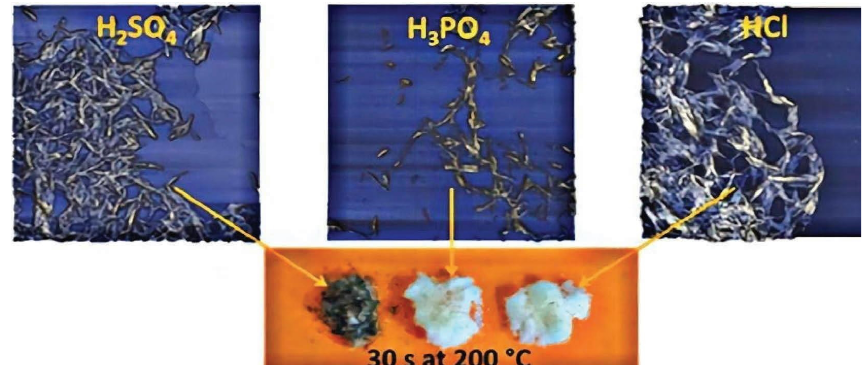
Figure 3: CNCs synthesis using sulfuric acid, phosphoric acid, and hydrochloric acid with the same treatment showed that the CNCs isolated by hydrochloric acid had the highest thermal stability [113]. Copyright and permission from American Chemical Society-2013.